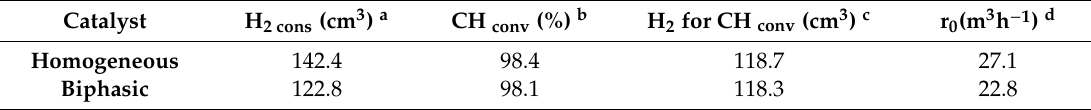
Table 1. Hydrogen consumption, CH conversion and H 2 consumption calculated for the CH